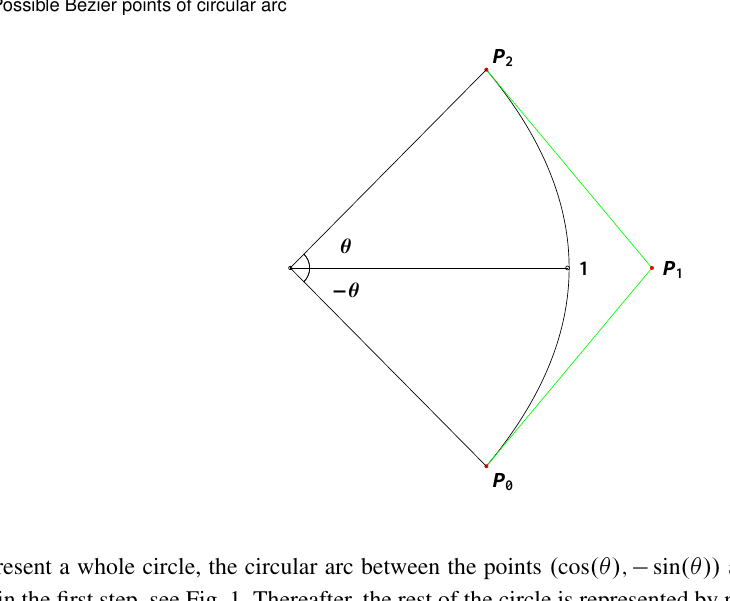
Fig. 2. Possible Bézier points of circular